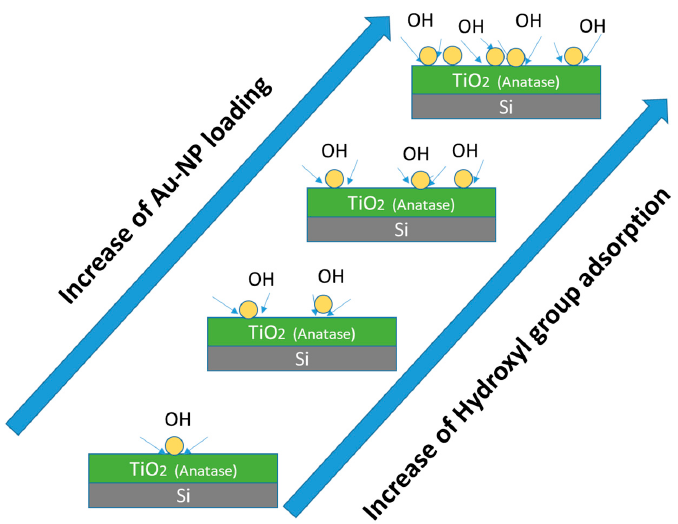
Figure 7. Schematic illustration of the effect of Au NP loading on the extent of hydroxyl group attachment to the anatase TiO 2 film surface.